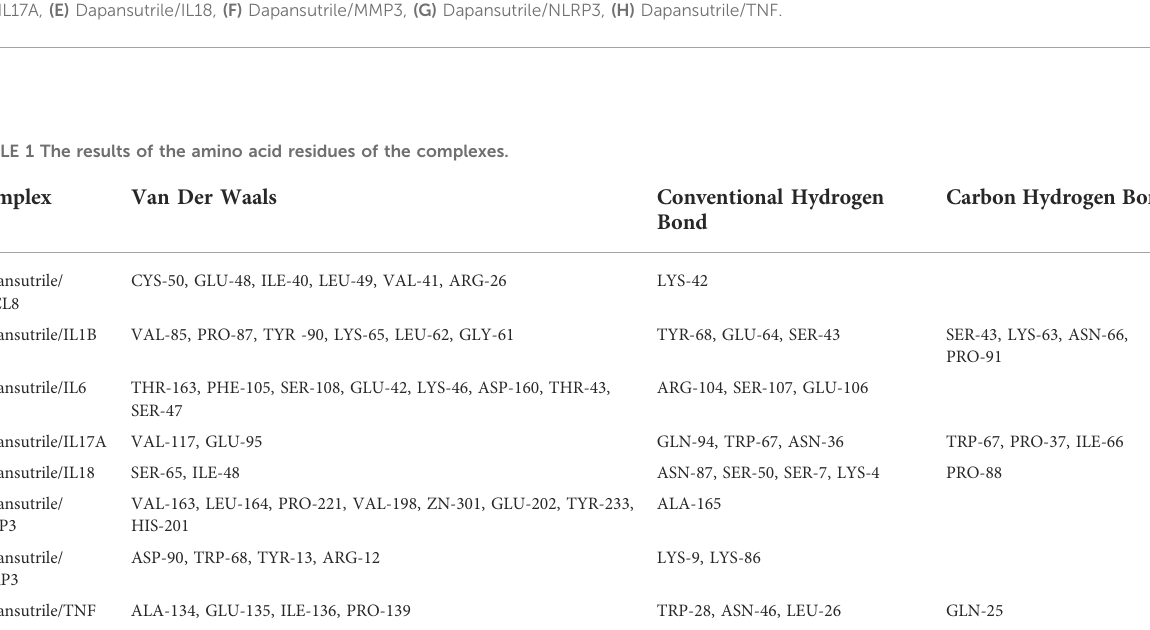
FIGURE 4 Molecular dockingofactive ingredientsand core targets. (A) Dapansutrile/CXCL8, (B) Dapansutrile/IL1B, (C) Dapansutrile/IL6, (D) Dapansutrile/